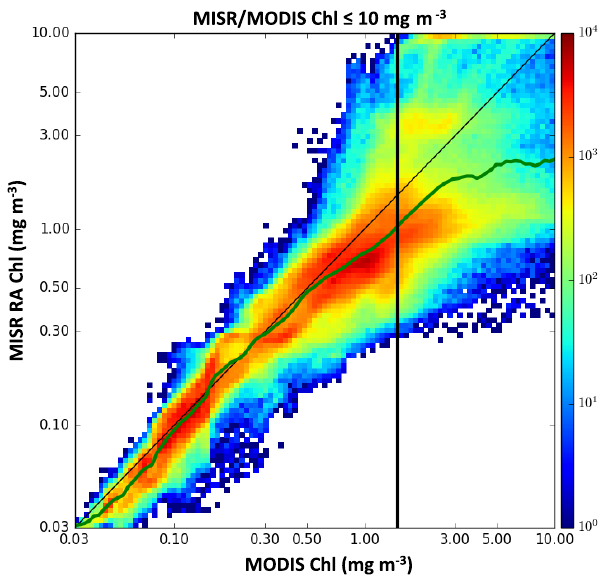
Figure 4. MISR–MODIS Chl scatter-density plot for Chl MODIS ≤ 10. The green line represents the mean MISR Chl value for each MODIS Chl bin, and the vertical black line represents Chl MODIS = 1 . 5. The bin size used for the green line is roughly 0.03 in log 10